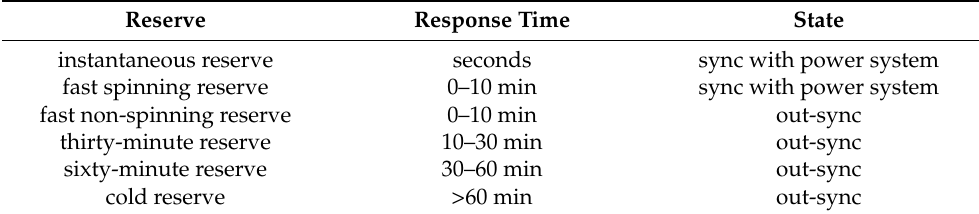
Table 1. Response time of the reserve.